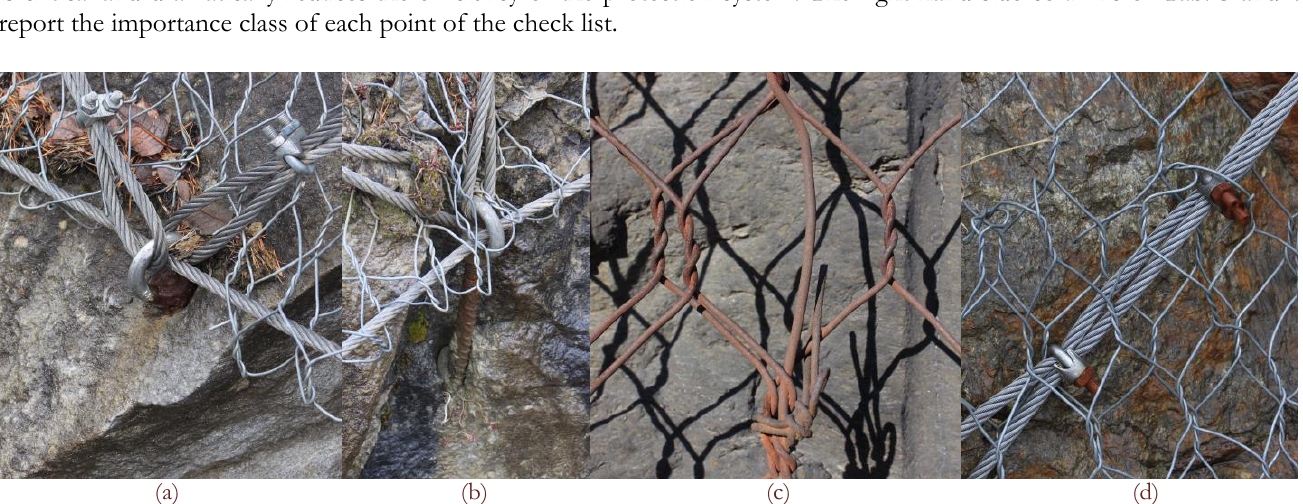
Figure 4: Examples of different damage levels attributed to various components. Different anchors types and connection with the ropes and the mesh: (a) Damage on the plate and/or on the head of the anchors – D1, (b) Unthreading of the anchors – D2, (c) Presence of corrosion and/or removal of the corrosion protections of the mesh – D2, (d) Presence of corroded zones and/or significant damage of the rope –